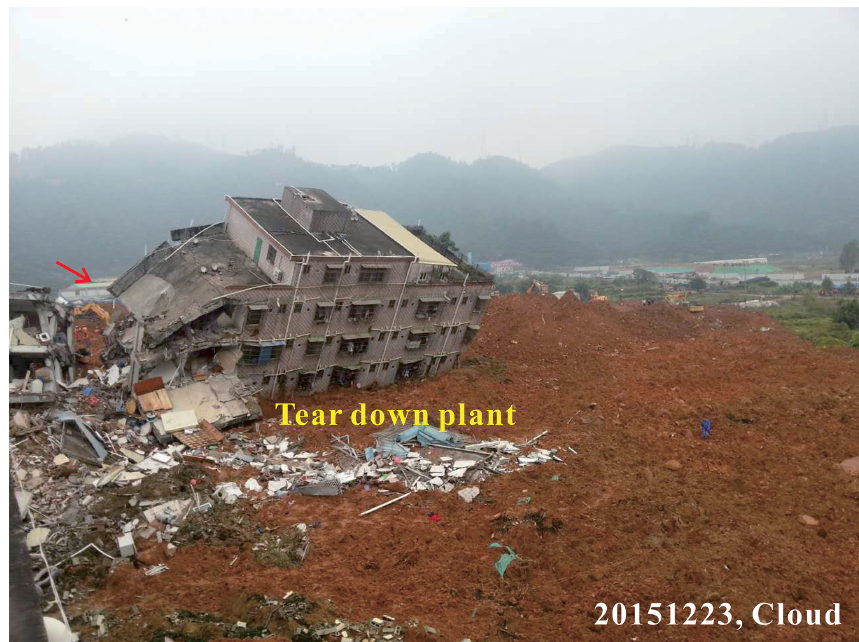
Figure 15. The damage of buildings in the industrial